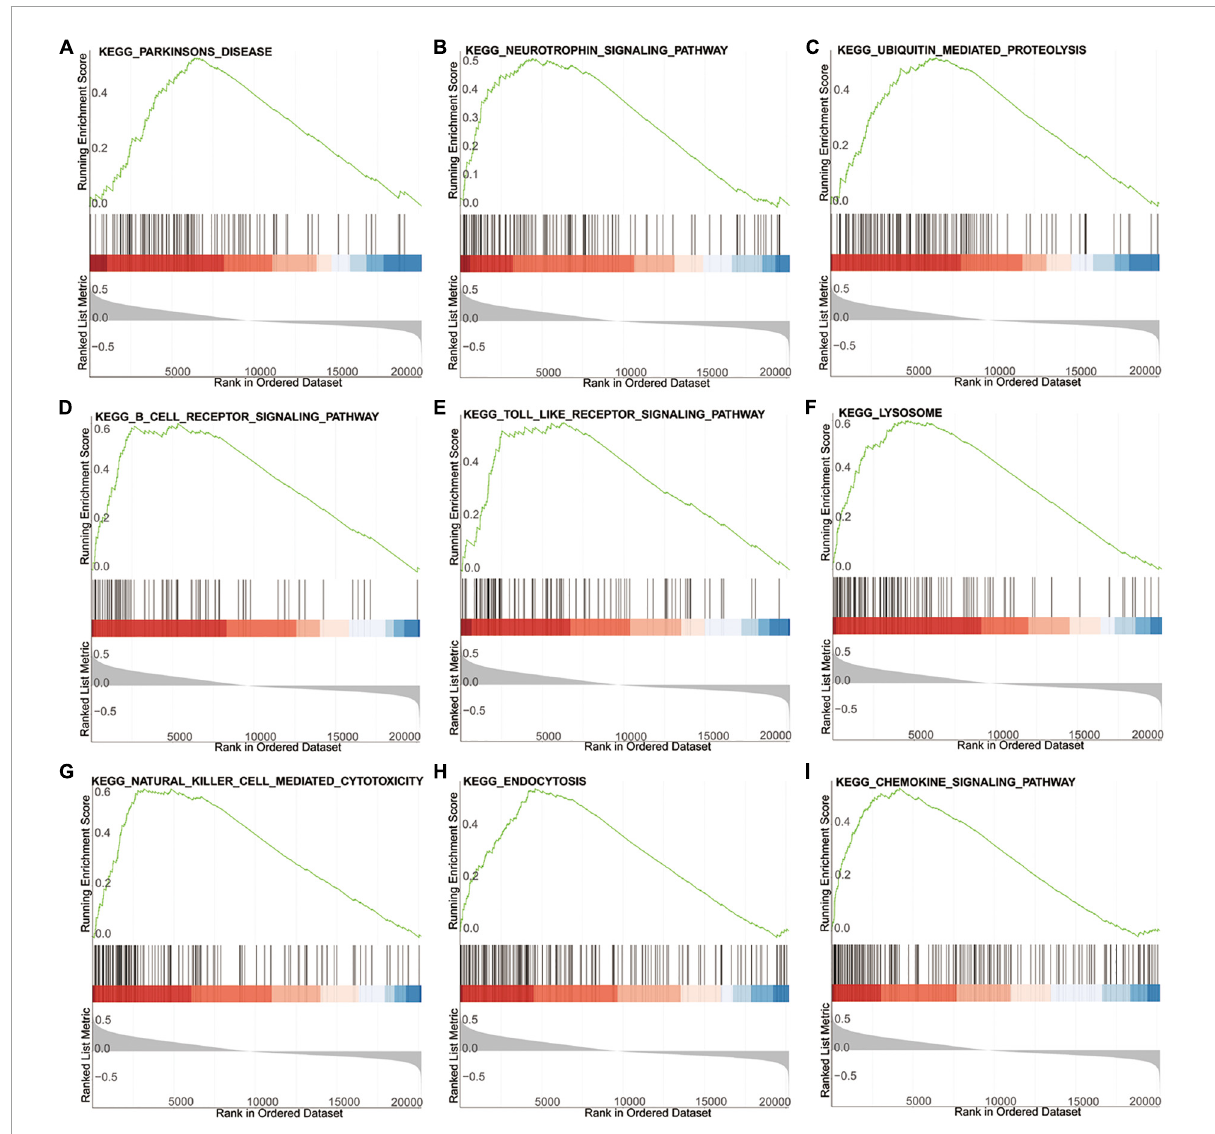
FIGURE5 GSEA of the high- and low-risk group based on the diagnostic signature. (A–I) The top KEGG signaling pathways in high-risk group.